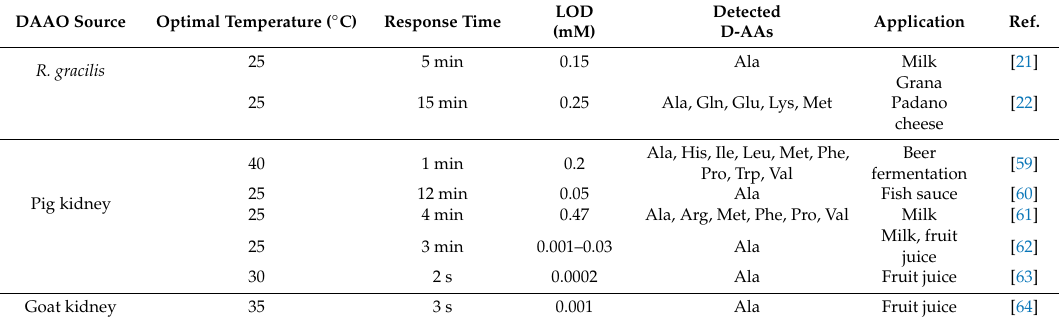
Table 1. Comparison of analytical properties of di ff erent electrochemical biosensors to detect D-enantiomers of amino acids (D-AAs) in foods. LOD: limit of detection; DAAO: D-amino acid oxidase. DAAO